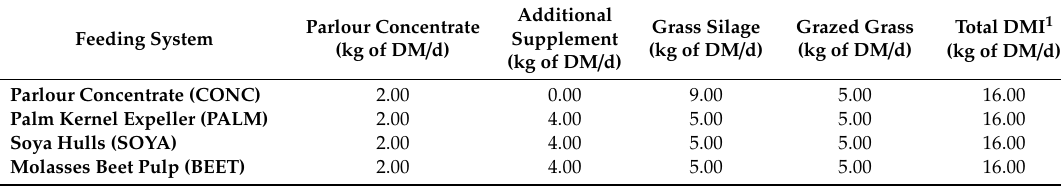
Table 1. Concentrate feed allocation and forage allowance (grazed grass and grass silage) o ff ered daily throughout the experimental period.